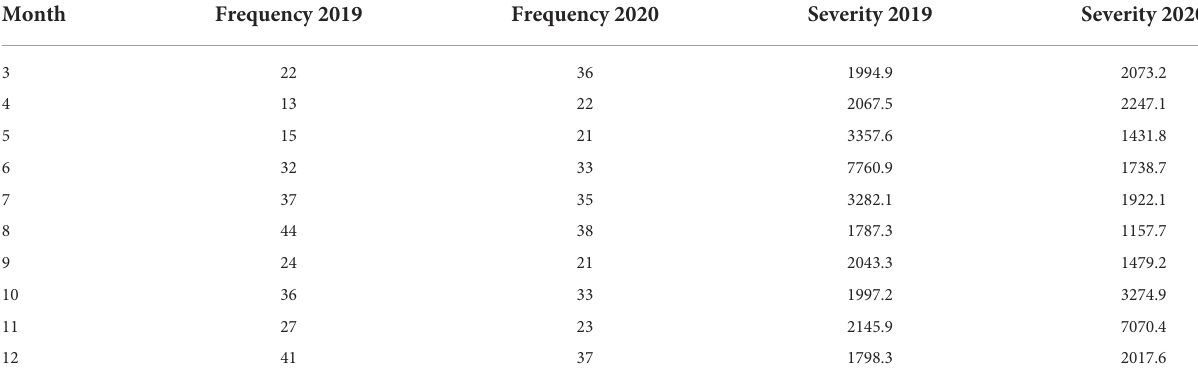
TABLE 4 Example of a table used for non-parametric